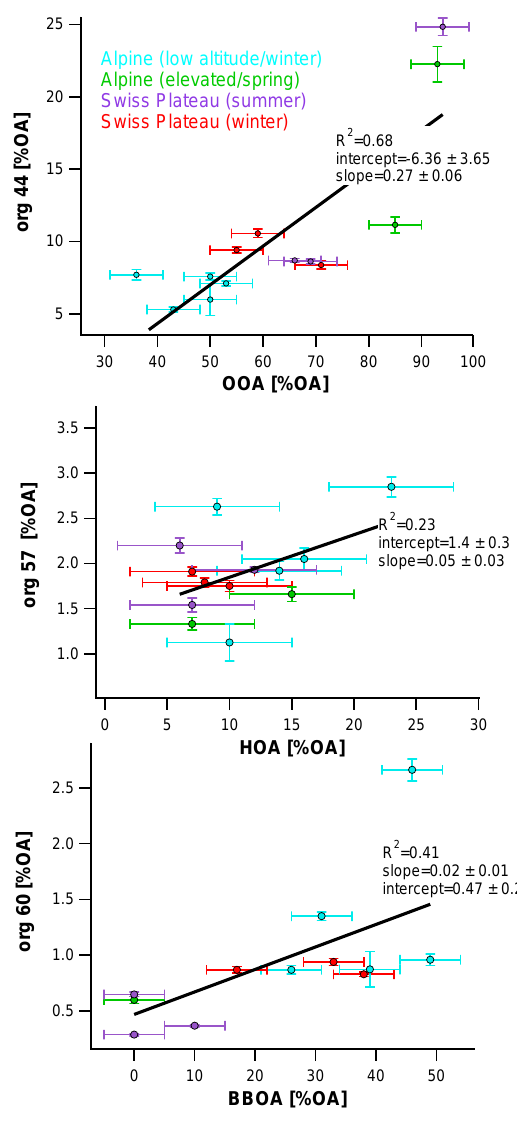
Fig. 4. Relation between organic m/z ’s 44, 57, 60 (measured) and OOA, HOA, and BBOA (retrieved by FA-AMS) (see Sect. 3.2). Results were normalized by OA (measured). Slope and inter- cept (orthogonal regression) are represented by solid black lines. The vertical bars represent the standard deviations of the mean ratios organic m/z i ( i =44,57,60) divided by OA, ( m/z i )/(OA), q sd . mean (m/z i ) 2 + sd . mean ( OA ) 2 . The horizontal bars represent an assumed ± 5% absolute uncertainty for the OA components (see caption of Fig. 3). OOA represents SV-OOA plus LV-OOA. BBOA was set to 0% in data sets where it could not be identified by means of